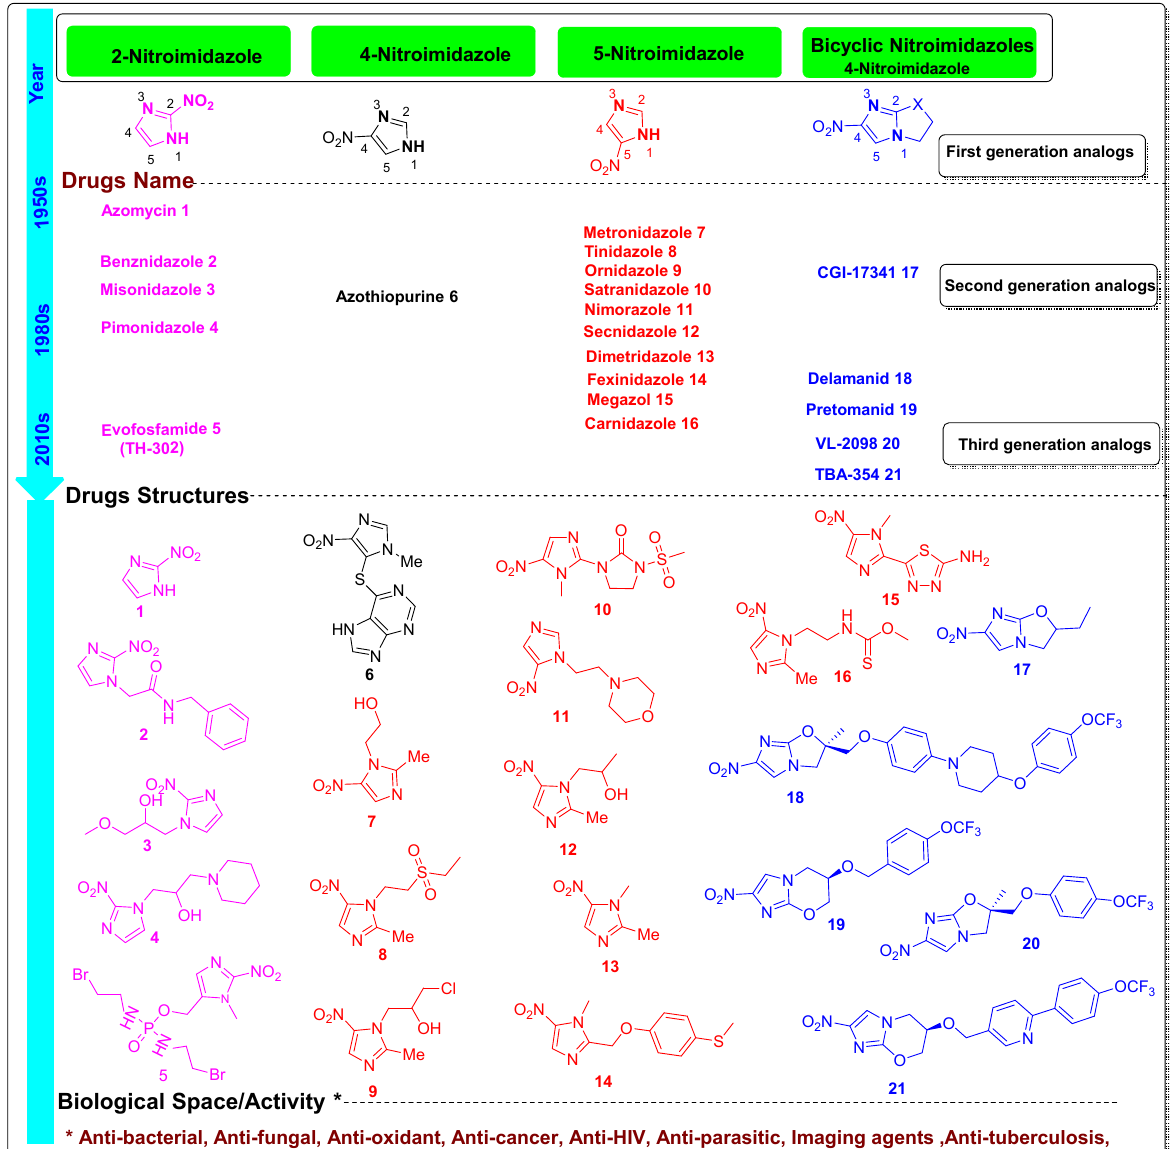
Figure 1. Timeline and selected related chemical structures of nitroimidazole series. The journey of nitroimidazole in drug discovery started with a discovery made by Maeda et al. in 1953 with the isolation of a compound from the culture of bacteria Nacar- dia mesenterica [4]. In 1955, Nakamura established its structure as 2-nitroimidazole [5]. Later, 2-nitroimidazole was also isolated from other bacterial strains such as Streptomyces, Trichomonas, etc. Azomycin 1 has shown potent activity against trichomoniasis [1], a sexually transmitted parasitic disease caused by Trichomonas vaginalis , which inspired the researchers of Rho ̂ ne-Poulenc for its derivatization, but all attempts toward its synthesis were unsuccessful. Rho ̂ ne-Poulenc researchers shifted their attention to the synthesis of 5-nitroimidazole regio-isomers, which fortuitously led to the identification of Metronida- zole 7 and other related drugs, discussed in depth in upcoming sections (Figure